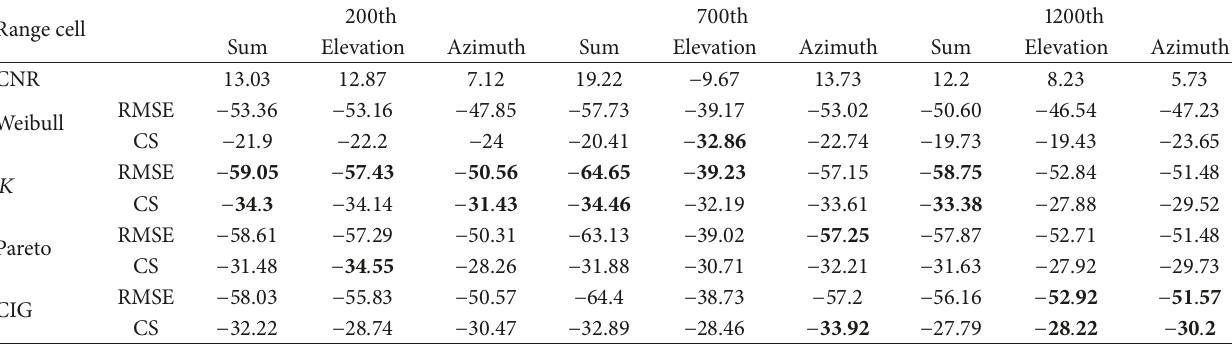
Table 5: RMSE and CS test of the different theoretical PDFs for DS1 (in dB).